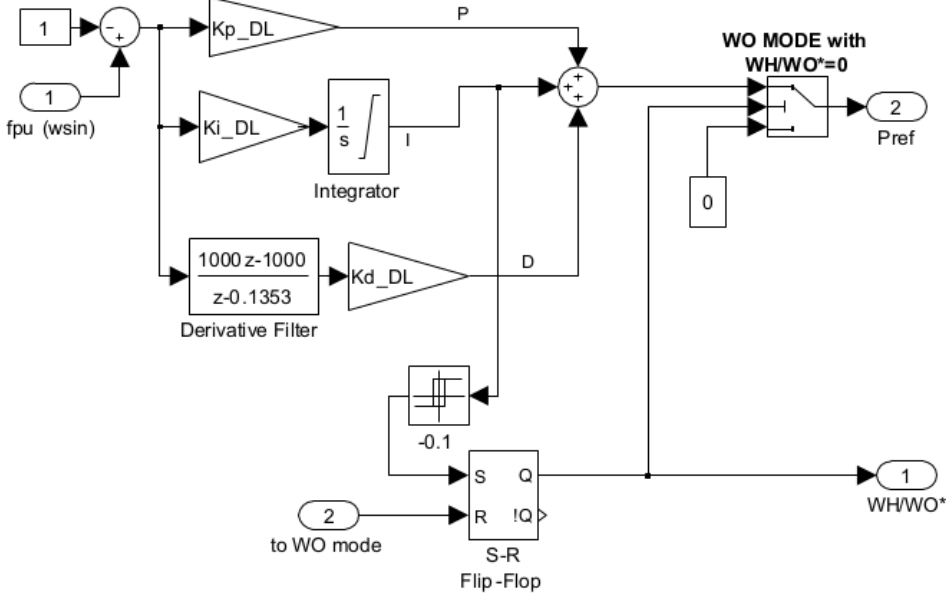
Figure 7. Dump load control Simulink